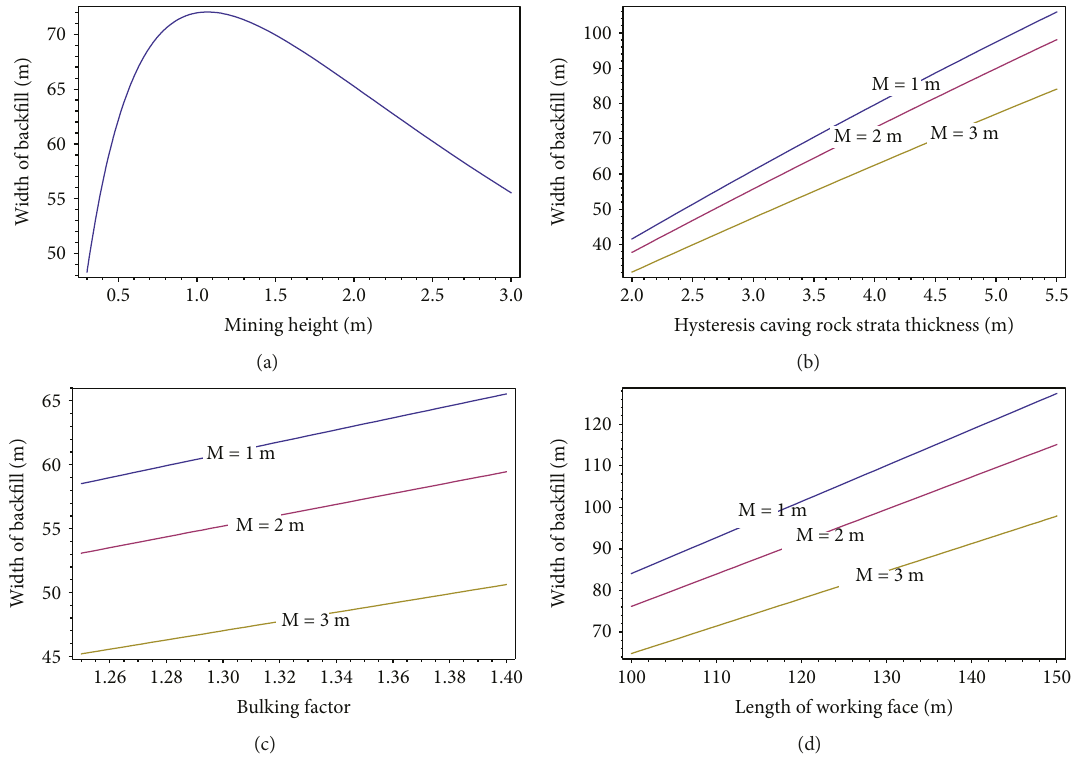
Figure 4: Variation in the width of the back fi ll with di ff erent operational